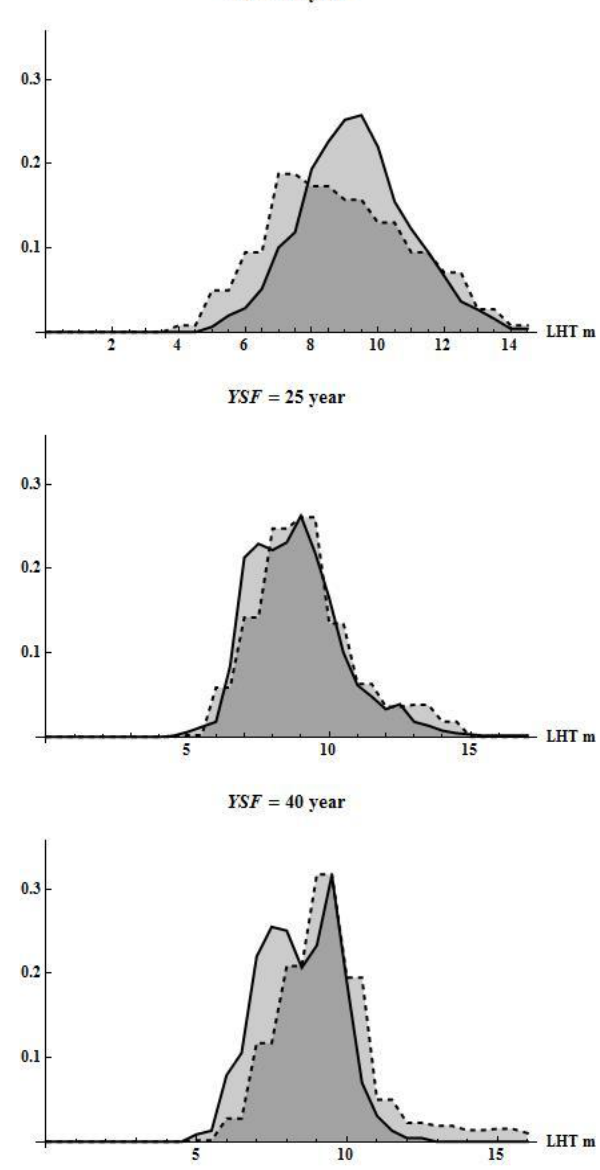
Figure 5. Three randomly selected examples of probability distributions (34) of LHT outline) classified as a post-fire canopy (Table 1, Step 1). The distribution of LHT indicated (dashed